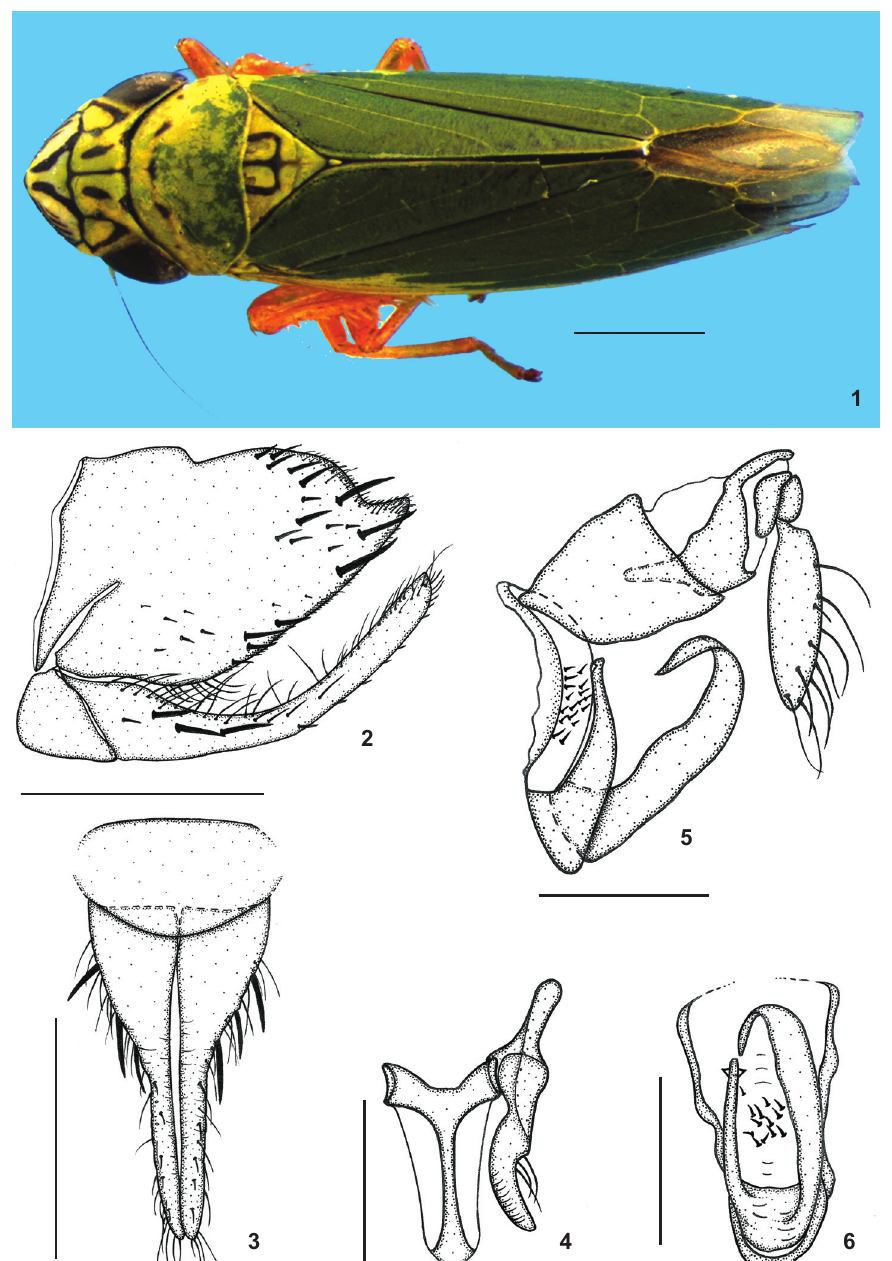
Figures 1-6. Fingeriana reflexa sp. nov. : (1) Male paratype body, dorsal view; (2-6) Male holotype genitalia: (2) pygofer, valve and subgenital plate, lateral view; (3) valve and subgenital plates, ventral view; (4) connective and style, dorsal view; (5) aedeagus and anal tube, lateral view; (6) aedeagus, caudoventral view. Scale bars: 1 = 1 mm, 2-3 = 0.5 mm, 4-6 = 0.25 mm. Length. Male: holotype, 5.9 mm, paratype, 6.4 mm. Female